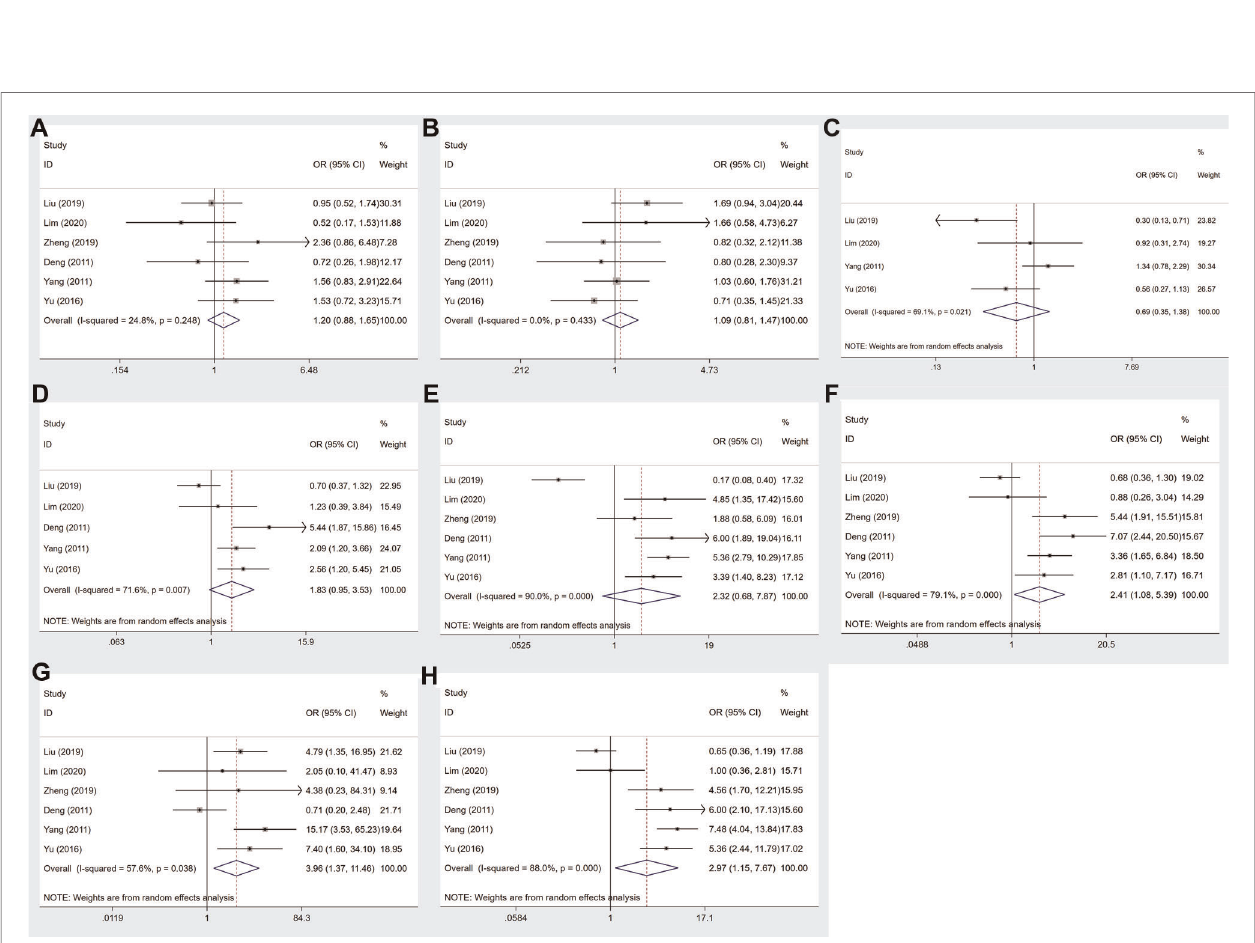
FIGURE 3 | Forest plots for the association of USP22 expression with clinicopathological parameters: ( A ) gender, ( B ) age, ( C ) tumor size, ( D ) tumor differentiation, ( E ) depth of invasion, ( F ) lymph node metastasis, ( G ) distant metastasis and ( H ) TNM stage.